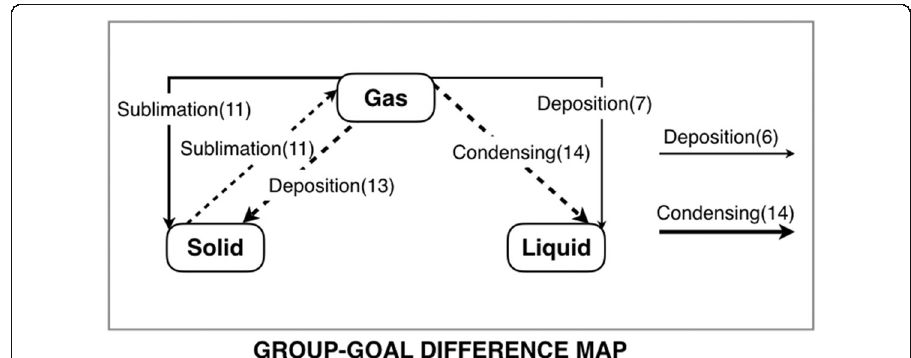
Fig. 3 An example of the group-goal difference